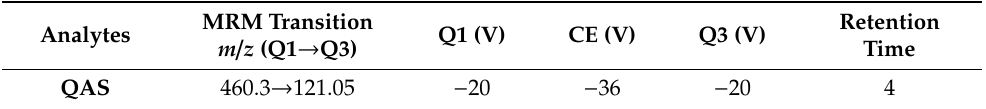
Table 1. Mass spectrometric parameters for QAS: precursor to fragment ion transition, voltage potential (Q1), collision energy (CE), and voltage potential